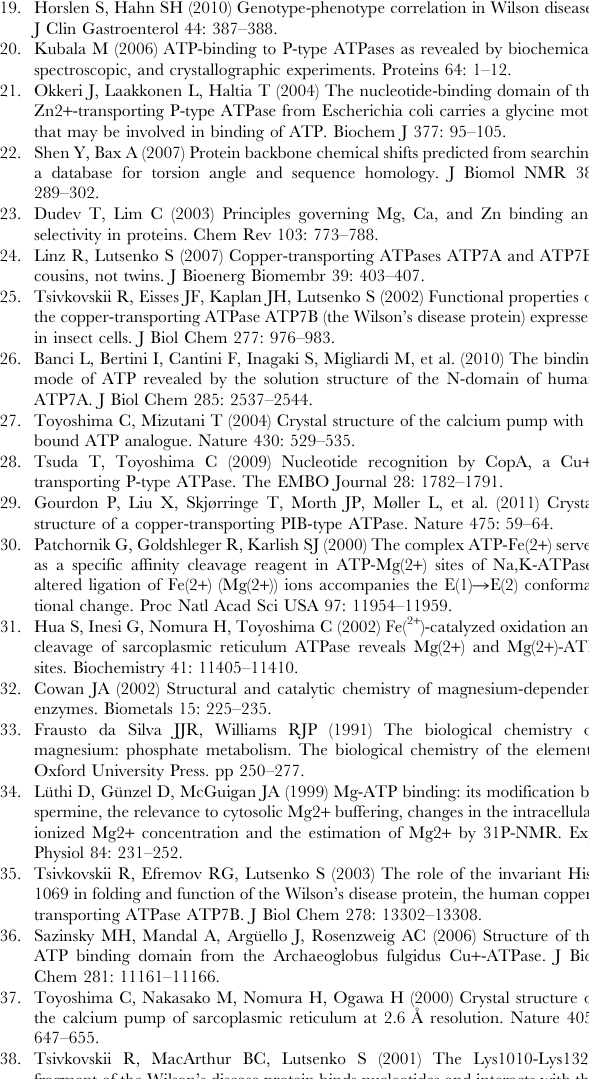
50 ns duration. Protein (shortened dynamic loop, SL), ATP and water molecules, magnesium atom and side-chain residues are represented in cartoon, ball and stick, VdW, and tube, respectively. Hydrogen bonds are shown in doted line. Table S1 Structural and experimental information used to propose an initial binding site for ATP in the molecular dynamics simulations. The residues highlighted in yellow green belong to the glycine loop and light blue for the coordination